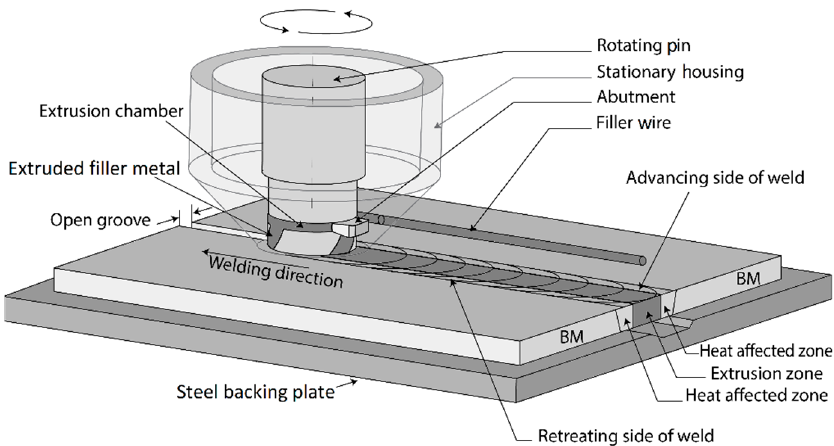
Figure 1. Schematic illustration of Hybrid Metal Extrusion and Bonding (HYB) PinPoint extruder in a butt ‐ welding situation.